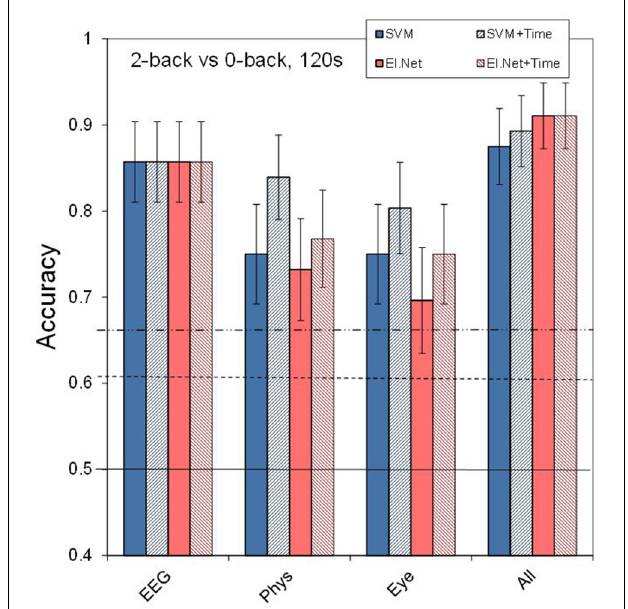
FIGURE 4 | Classification performance in the default condition (2- vs. 0-back, 120s) for the different sensor types and using all available input. The striped bars show the effect of adding the time feature. Conventions as in Figure 1